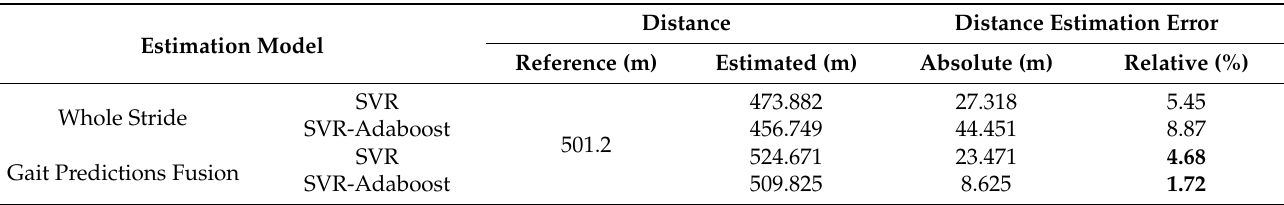
Table 7. Gait segmentation results for different methods in F-score values. Best results for each speed group are highlighted in bold